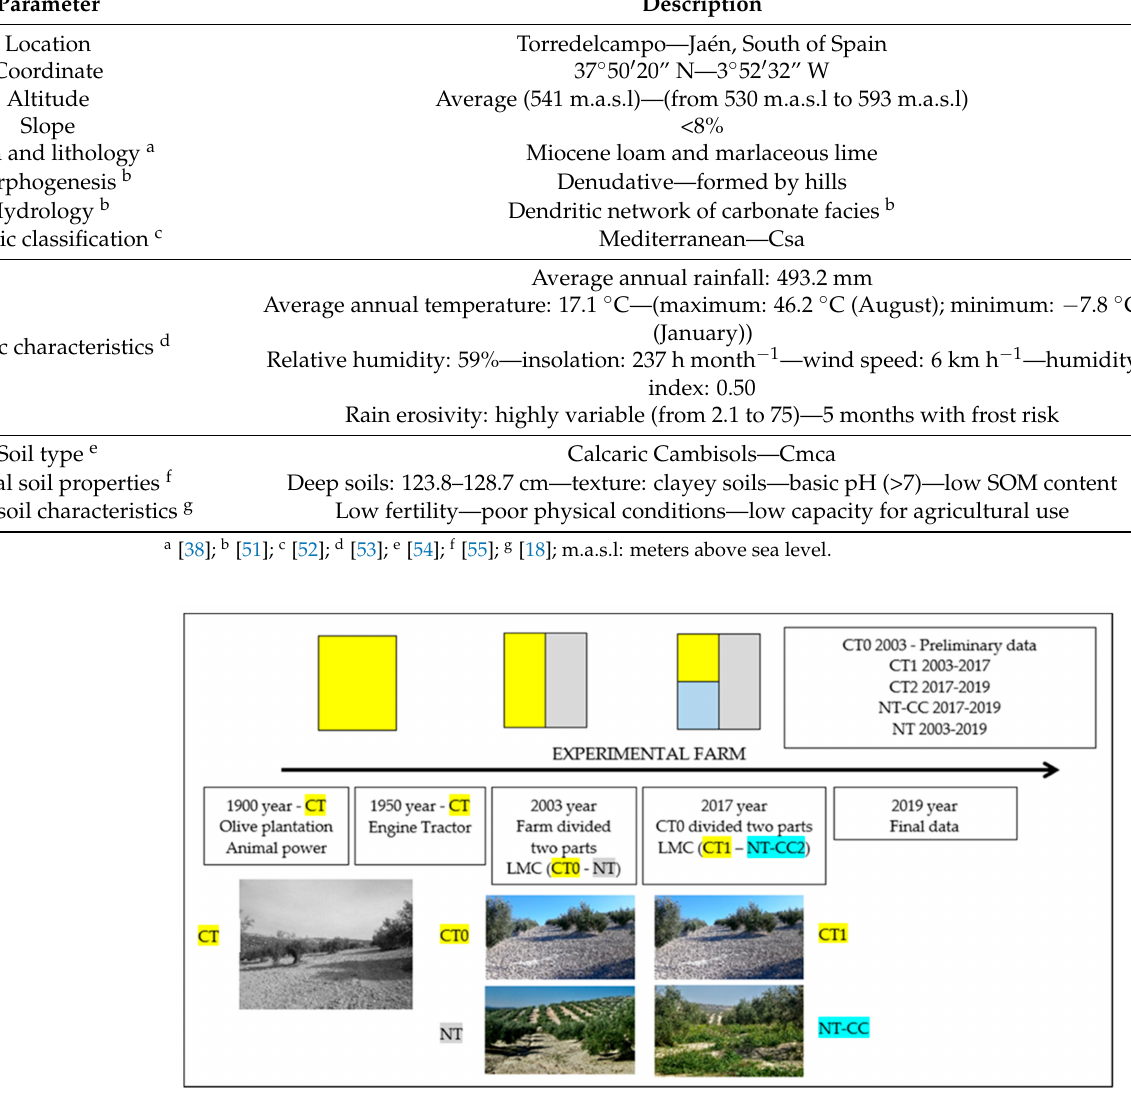
Figure 2. Period of the study farm. LMN: land management change; CT: conventional tillage; CT0: conventional tillage 2003; NT: no tillage; CT1: conventional tillage 2017; and NT-CC: no tillage with cover crops